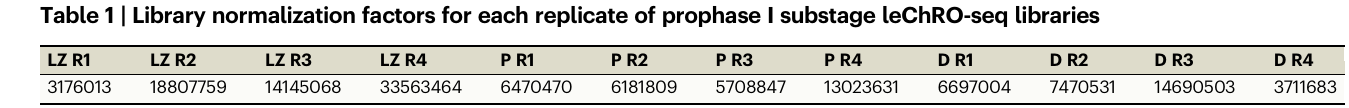
Table 1 | Library normalization factors for each replicate of prophase I substage leChRO-seq libraries LZ R1 LZ R2 LZ R3 LZ